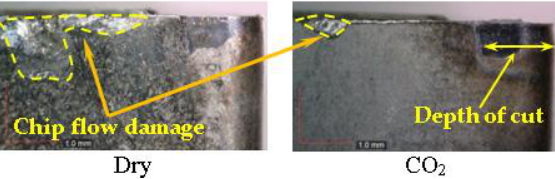
Figure 10. Images of the chip flow damage occurring after 500 mm cutting length.